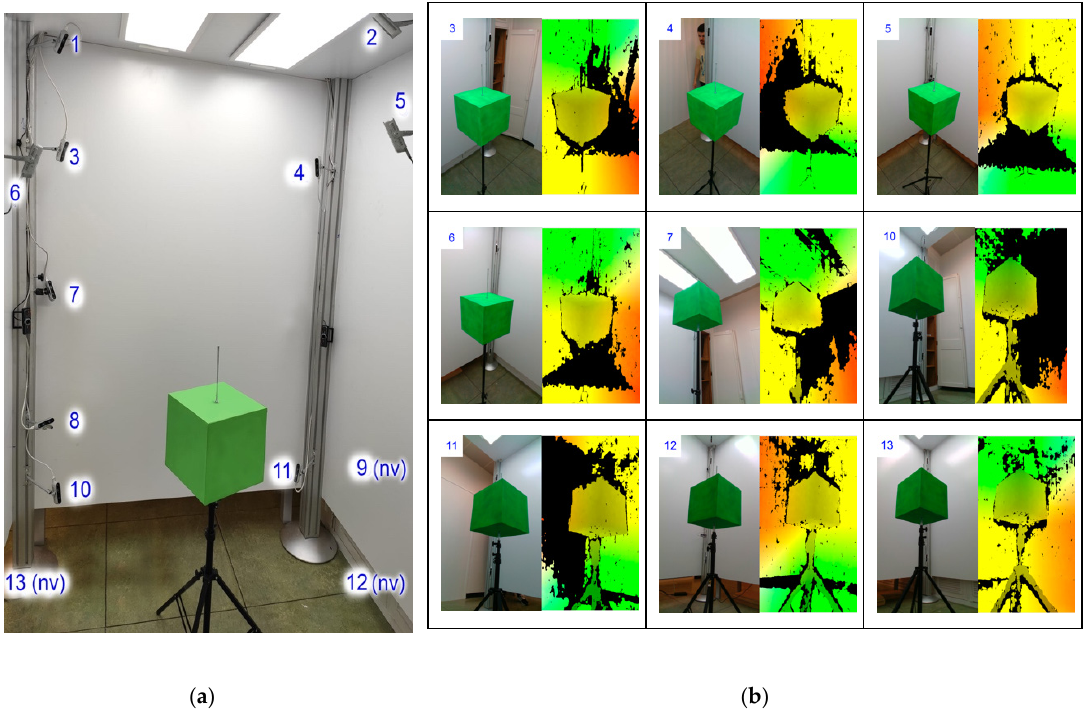
Figure 2. ( a ) Experimental set-up 13 RGB-D cameras. “nv” means a camera not visible in this image. ( b ) Acquisition results for the cameras (color and depth images). The green cube has been used for extrinsic calibration. Images from high, intermediate and super-low levels are shown.